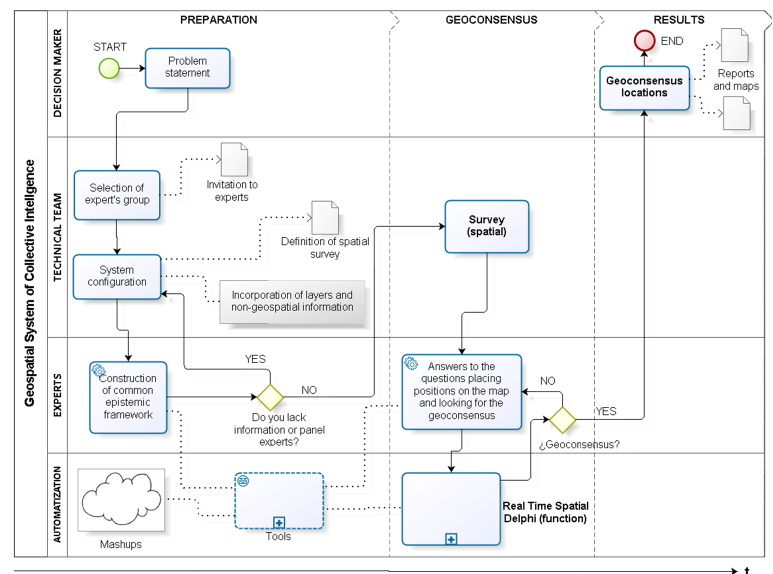
Figure 2. Scheme of the methodological process (elaborated by the authors).